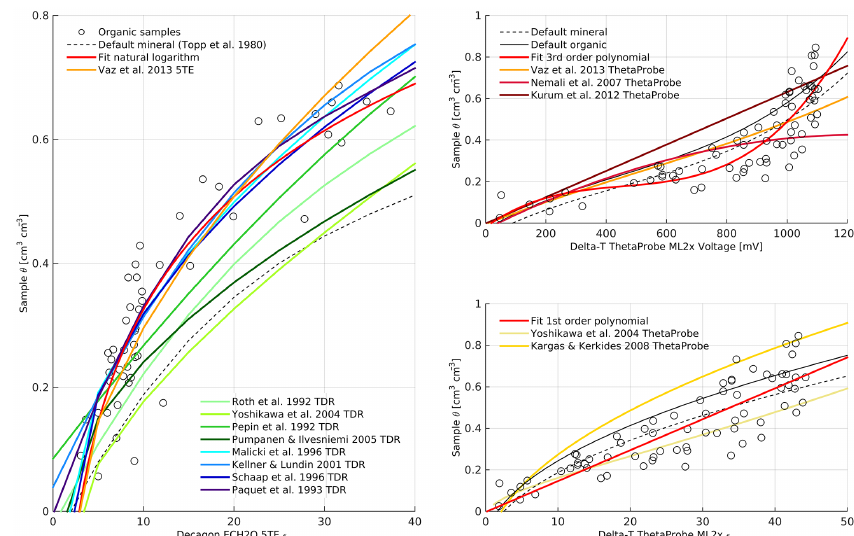
Figure 4. Comparison between reported petrophysical and empirical relationships applied to our data measured in organic soil layers for the Decagon 5TE apparent relative permittivity ε a (left panel), and ThetaProbe voltage (mV) (upper right panel) as well as ε a (lower right panel) against volumetric moisture content θ including respective manufacturer’s default calibration curves and best